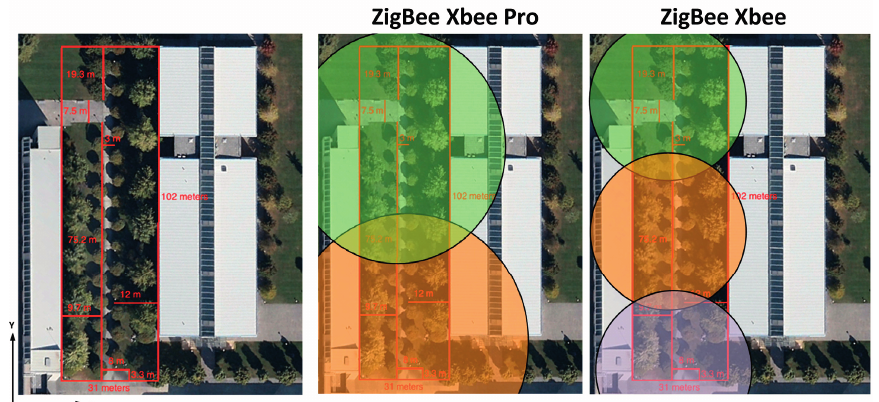
Figure 13. Radioplanning coverage for different technologies within the considered vegetation